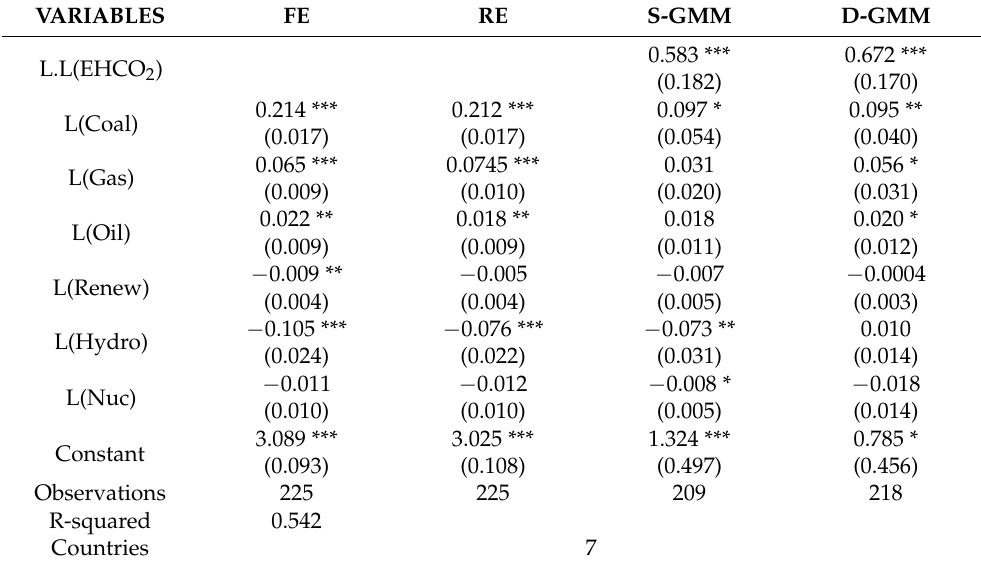
Table 4. Dynamic and Static Panel Regression Result (L(EHCO 2